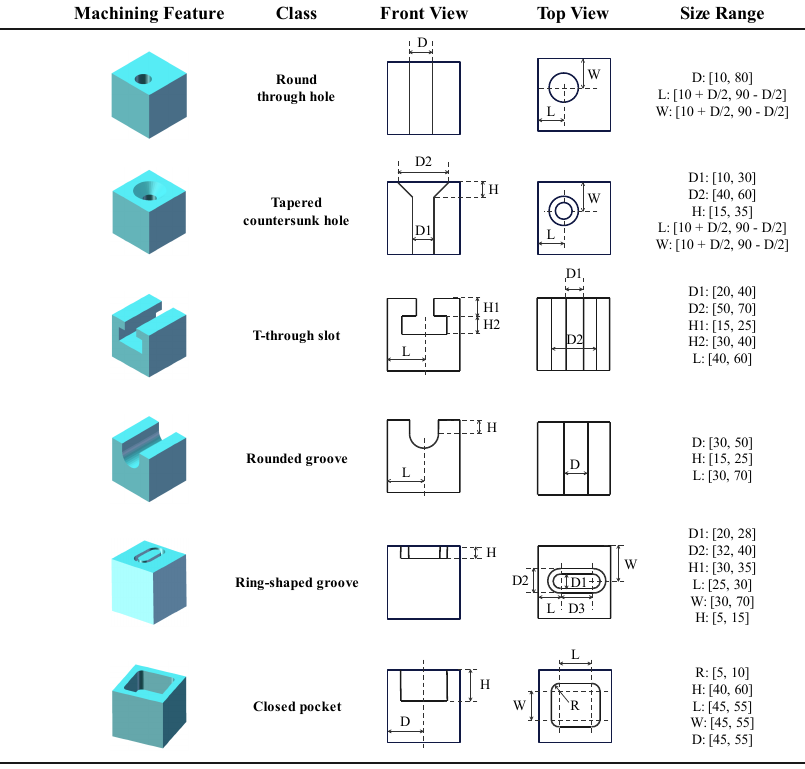
Figure 1. Some non-rotary feature models contained in